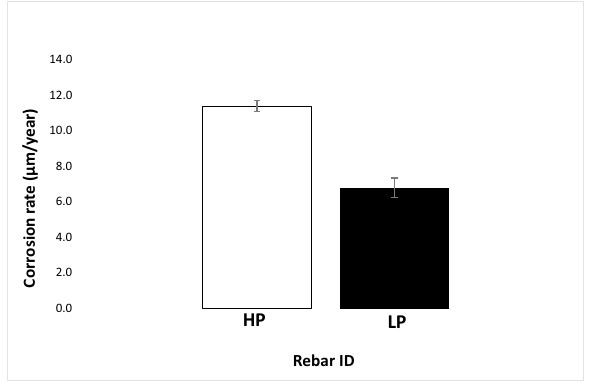
Figure 3. Corrosion rate of the HP and LP steel rebars in chloride free SPSL solution after seven cycles of wet/ dry treatments.